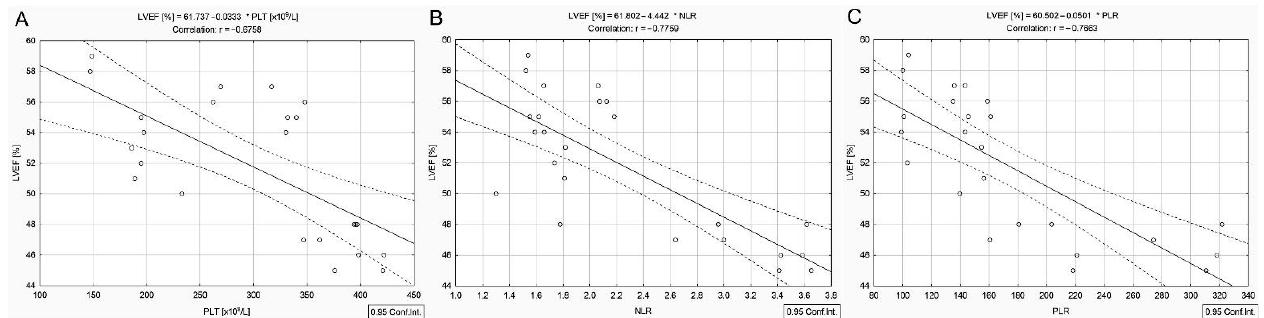
Figure 4. Correlations between LVEF and BMI ( A ), Ca 2+ ( B ), and ALP ( C ) in differentiated thyroid cancer patients with type 2 diabetes mellitus.